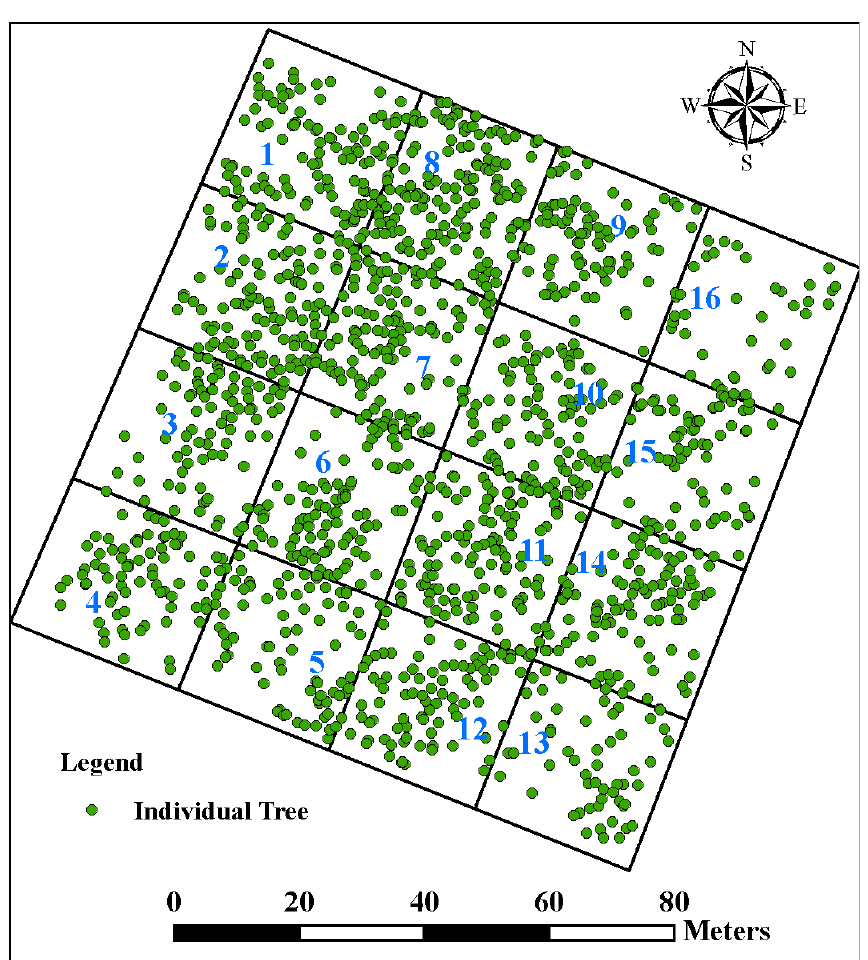
Figure 2. The spatial distribution of the field-measured individual trees in the super-plot with 16